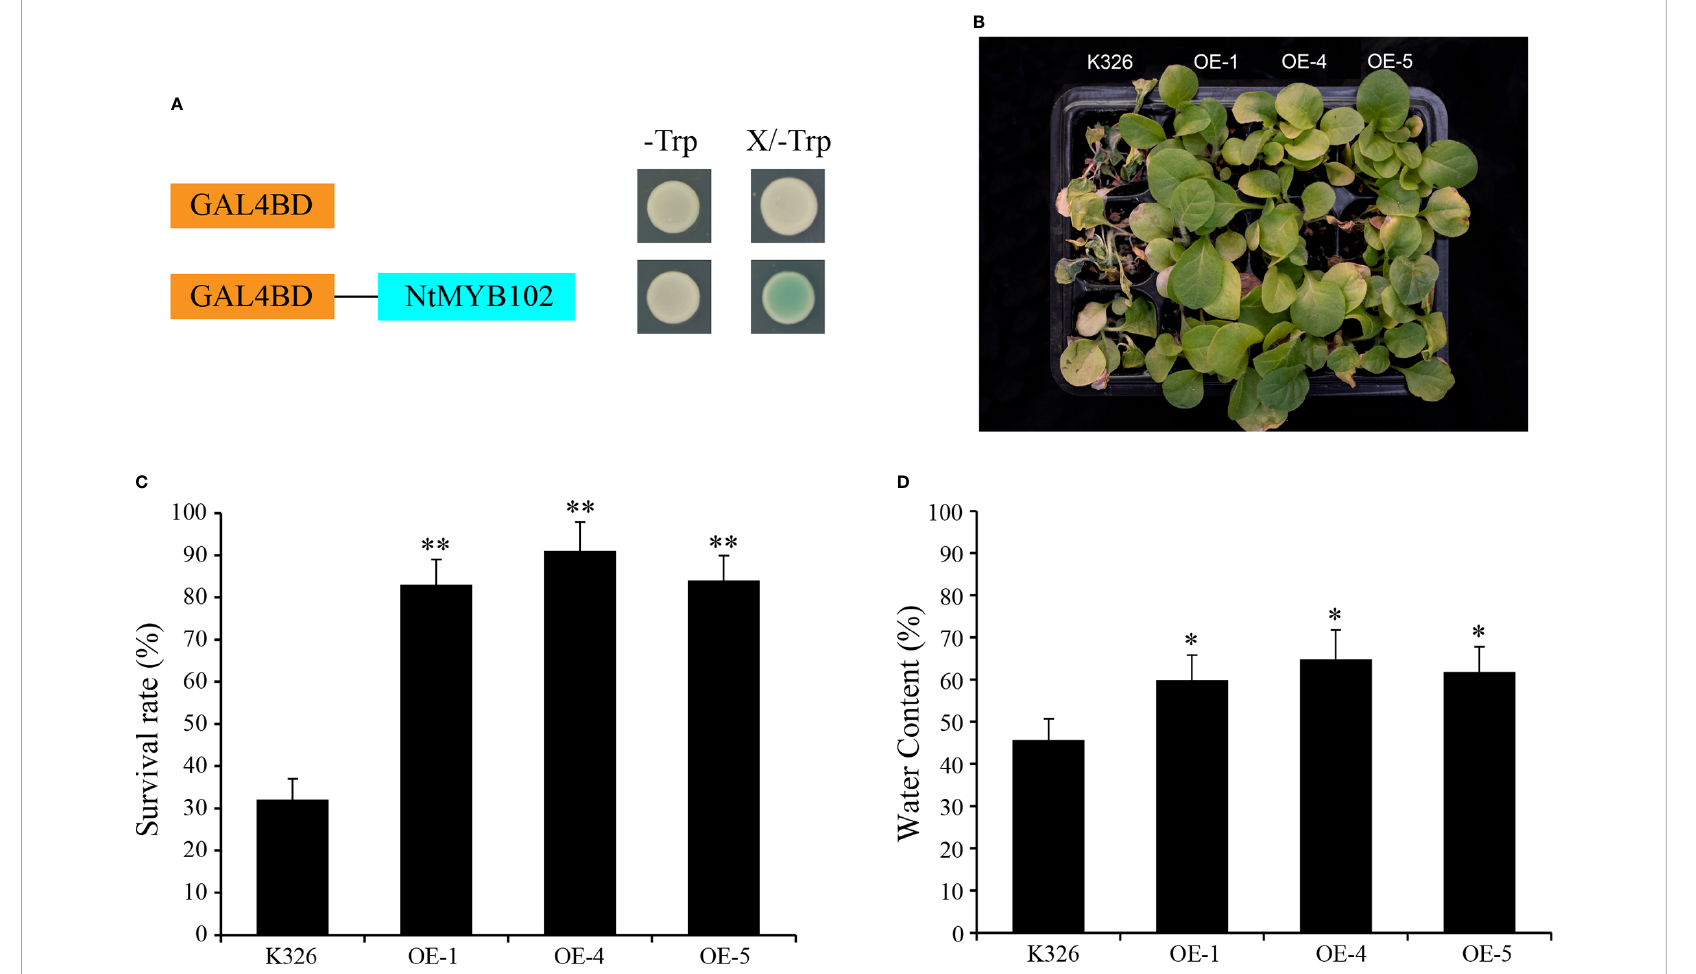
FIGURE 7 The function of NtMYB102 in drought tolerance. (A) Transactivation analysis of NtMYB102 in yeast. (B) Phenotypes of overexpression lines and wild-type tobacco under drought stress. The overexpression lines displayed higher drought tolerance after 2 weeks of drought stress and three days of recovery. (C) The survival rates of the overexpression lines and wild-type tobacco. (D) The water content of detached leaves of overexpression lines and wild-type tobacco, which was calculated by comparing the weight of the leaves before/after the treatments. The values represent means ± SD. *p < 0.05, **p < 0.01 ( t